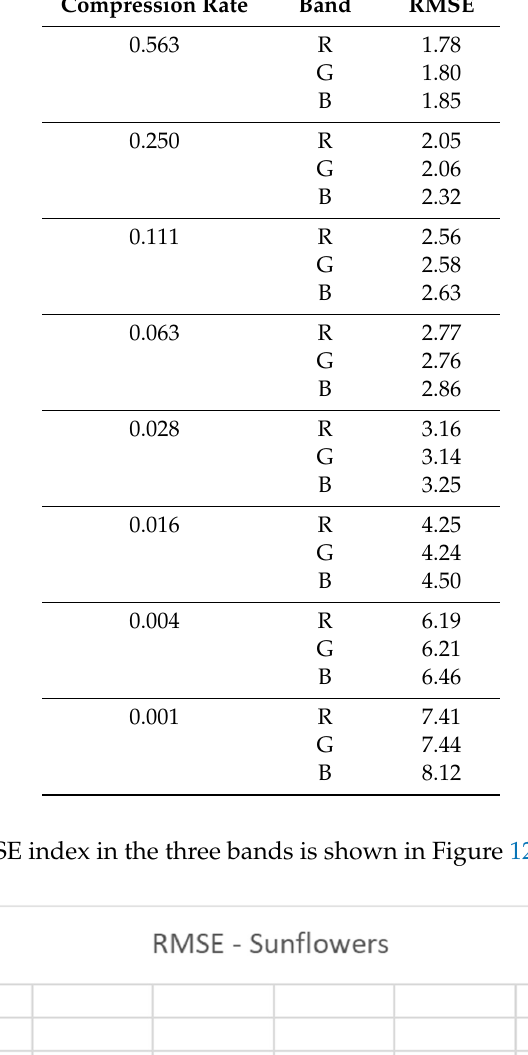
Table 2. RMSE measures for the image Sunflowers.